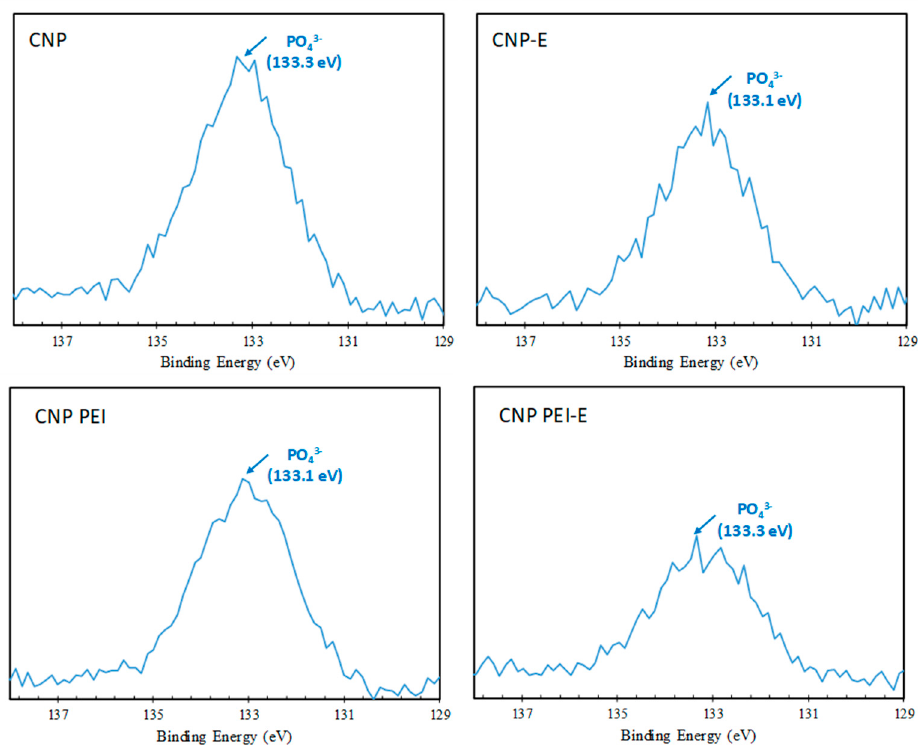
Figure 6. P 2p XPS spectra of CNP, CNP-E, CNP PEI, CNP PEI-E.